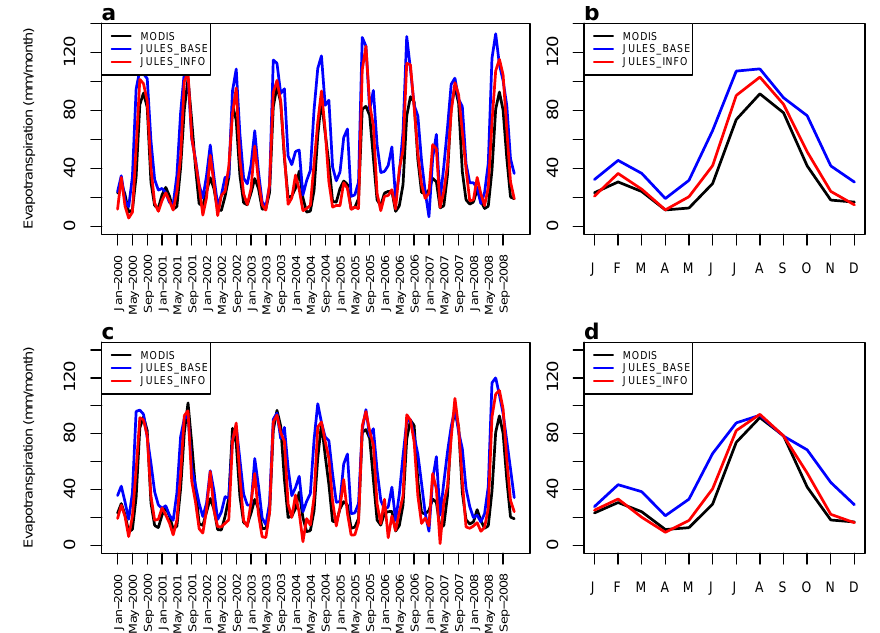
Figure 5. Comparison between MODIS ET and simulated ET by the two models: JULES-base and JULES-Info: (a) and (b) are with GMAO forcing data and (c) and (d) with TRMM and NCEP forcing data. The right-hand plots (b, d) show the mean seasonal cycle of evapotranspiration (units: mmmonth − 1 ) for each of the models, showing the mean bias per